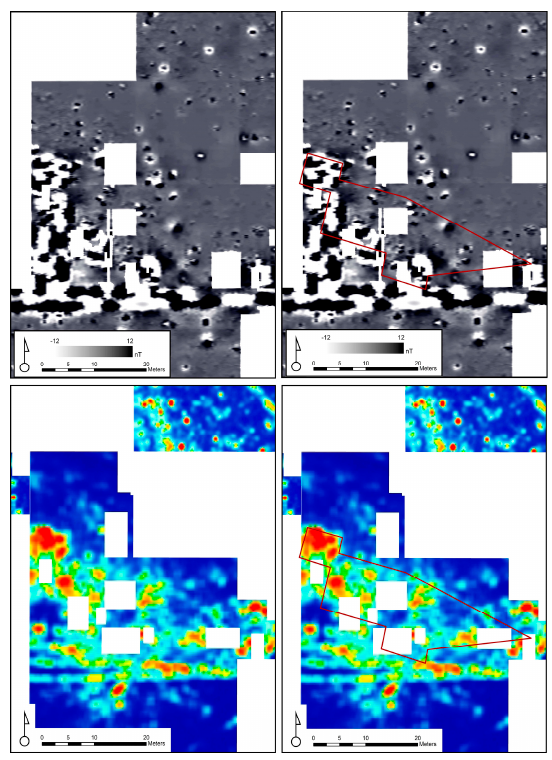
Figure 14. Magnetic gradiometry ( top ) and GPR ( bottom ) maps showing the architecture of San Marcos (I).